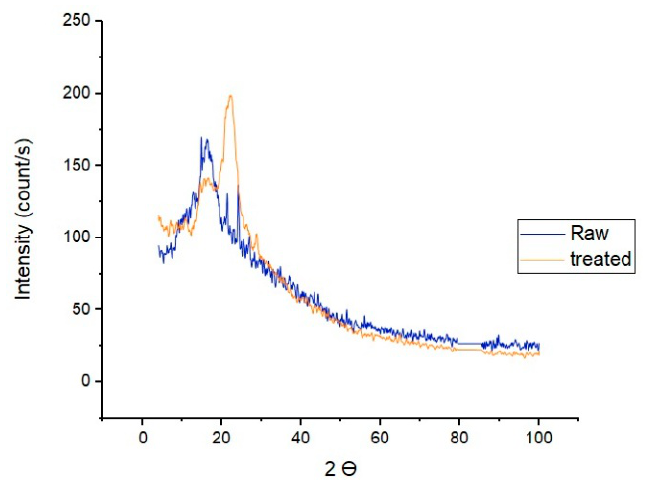
ff ractograms of raw and mechanically pretreated Figure 5. X-ray diffractograms of raw and mechanically pretreated barley. Figure 5. X-ray di